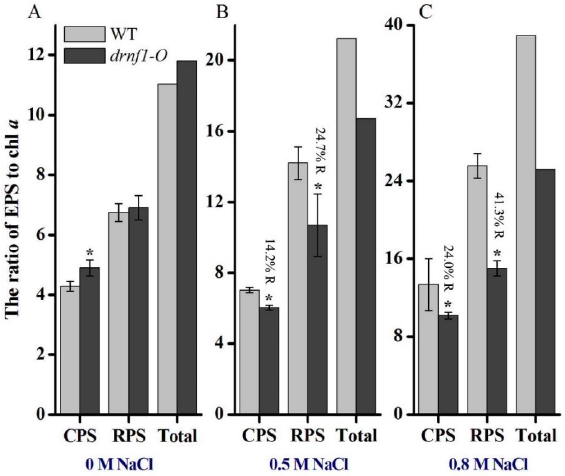
Figure 4. Production of total exopolysaccharide (EPS), capsular EPS (CPS), and released EPS (RPS) in WT and transgenic Synechocystis before ( A ) and after salt stresses ( B , C ) . Data are mean ± s.d. ( n = 3). Asterisks indicate significant differences ( p < 0.05) with respect to the WT under the same conditions (Student’s t -test). R: the reduction (relative to the WT control).